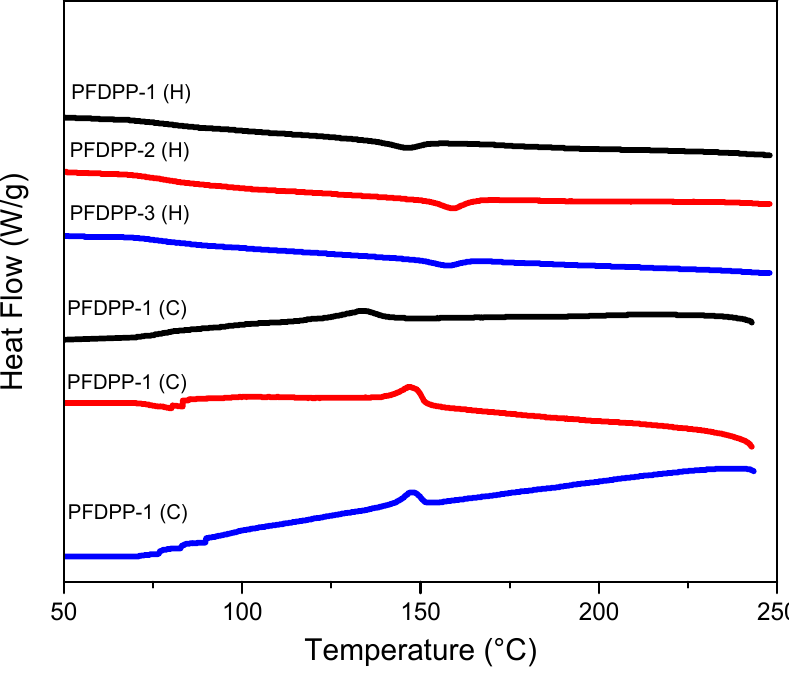
Table 2. Summary of thermal properties of PFDPP polymers obtained by DSC and TGA.